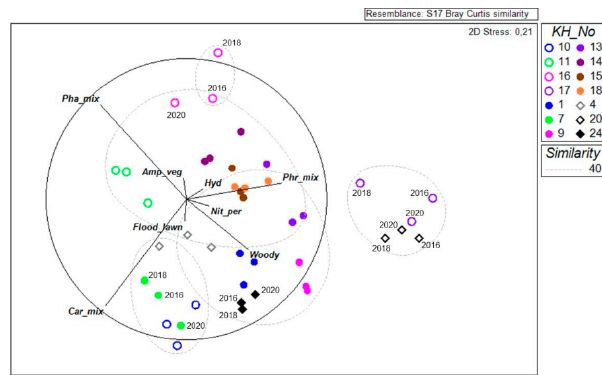
Figure 4. nMDS ordination representing differences in dominant plant communities among ket- tle holes and the three studied years (labeled for some examples) overlaid with dominant plant communities and groups of cluster analysis with 40%